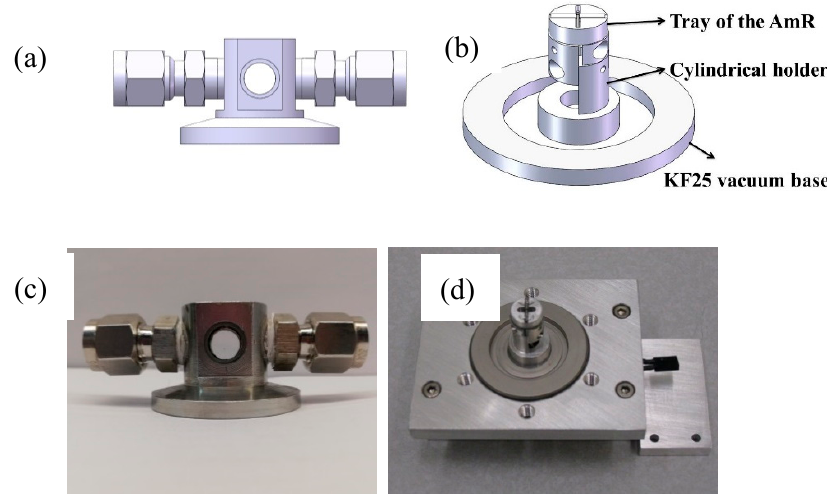
Figure 4. ( a ) CAD image of the KF25 vacuum cap; ( b ) CAD image of the KF25 vacuum base; ( c ) Photo of the KF25 cap; ( d ) Photo of the KF25 base.